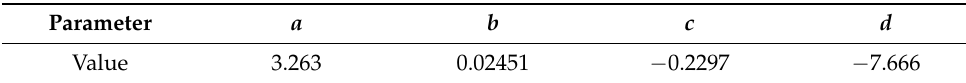
Table 1. Battery OCV curve parameters.